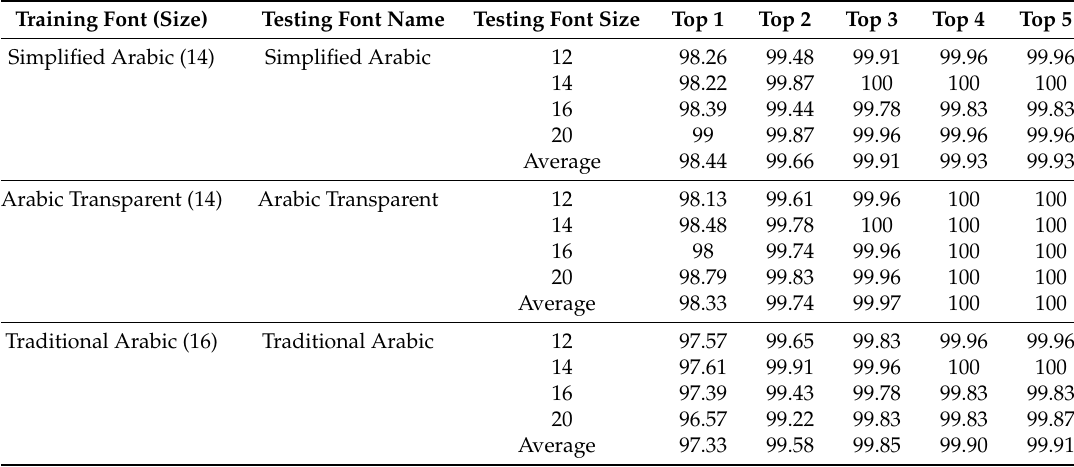
Table 2. Single font WRR (percent) for multi size fonts (12, 14, 16 and 20).